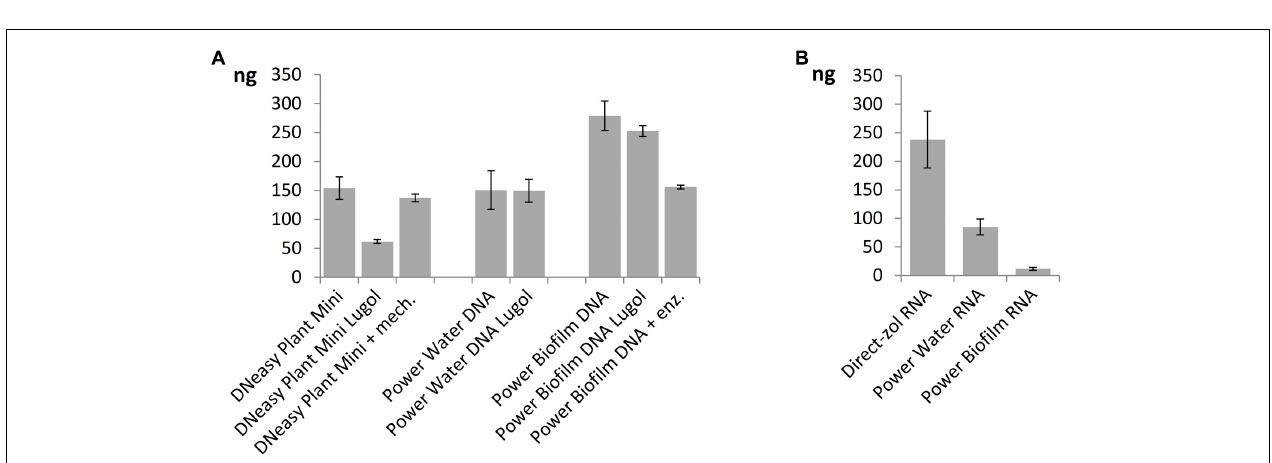
FIGURE 4 | The effect of trimming criteria on the NGS results of the model data of separately barcoded sequences of mock strains. (A) Torrent Suite 3 (cid:48) end trimming of reads (+3 (cid:48) ) retained the original relationship of barcoded reads as well as without trimming (–3 (cid:48) ) imported reads. (B) When 3 (cid:48) end trimmed (+3 (cid:48) , in Torrent Suite) reads were imported into the Mothur software and tight trimming procedures were applied, proportions of the strains became distorted. Resolving trimming lighter, proportions appeared more equal. The pipeline without 3 (cid:48) end trimming in Torrent Suite and moderate trimming in CLC was selected for further analyses.